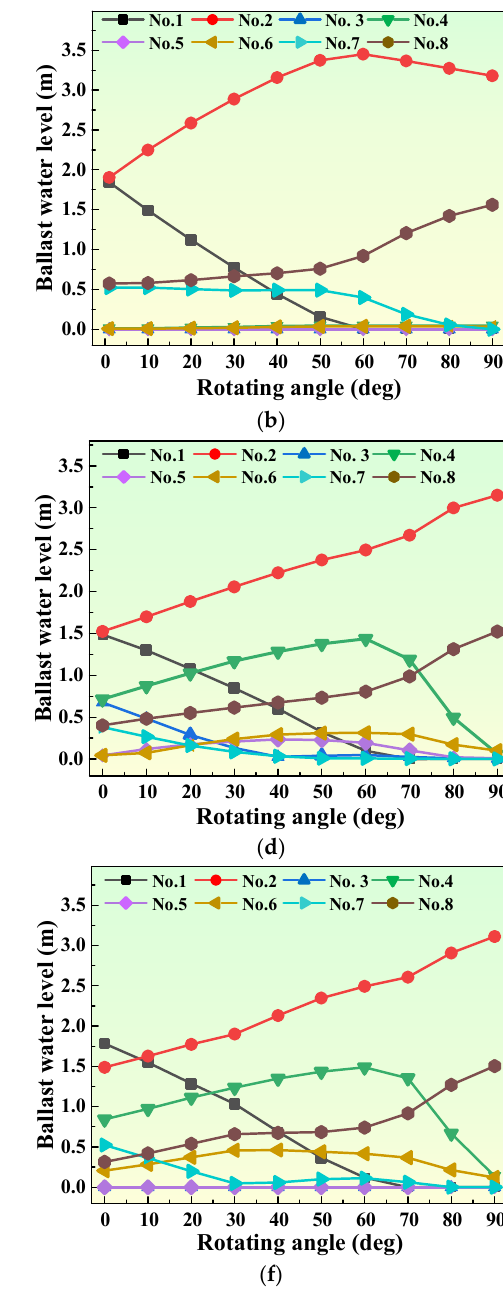
Figure 19. Allocation schemes solved by different algorithms. ( a ) AE scheme. ( b ) TOA algorithm. ( c ) Genetic algorithm (GA). ( d ) PSO algorithm. ( e ) Fuzzy-genetic algorithm (FGA). ( f ) FPSO algorithm.